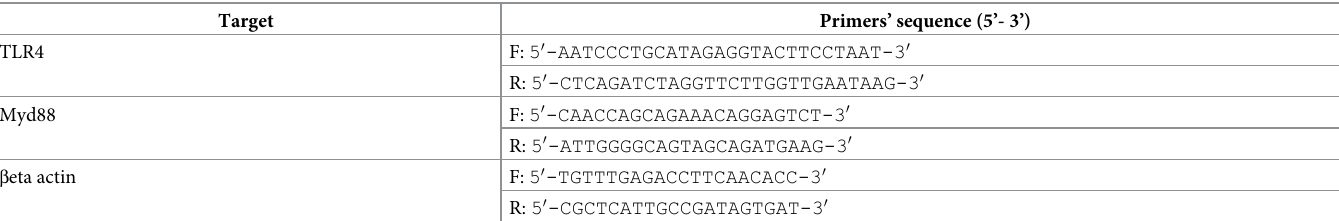
Table 1. The forward and reverse primers’ oligonucleotide sequences for TLR4 and Myd88 genes.